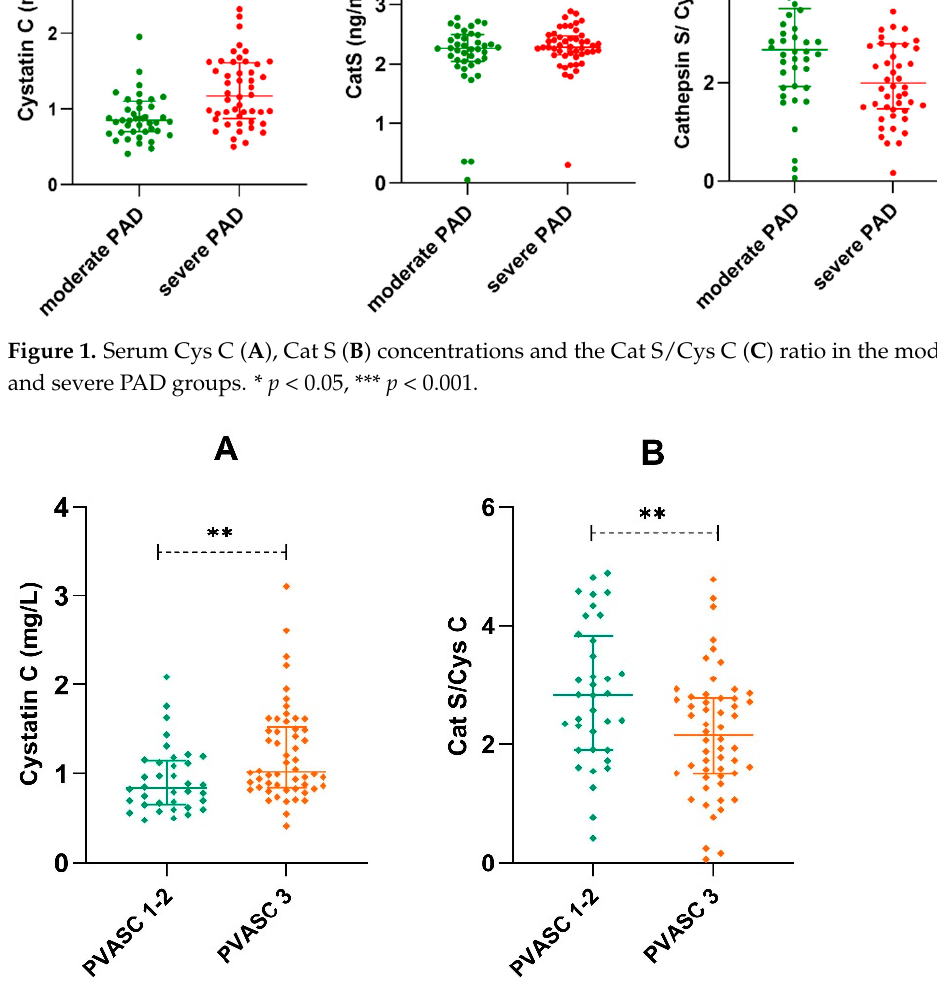
Figure 2. Serum Cys C concentrations ( A ) and the Cat S/Cys C ratio ( B ) in the groups with different vascular involvement. PVASC 1–2, one/two bed; PVASC 3, three bed involvement. ** p < 0.01.